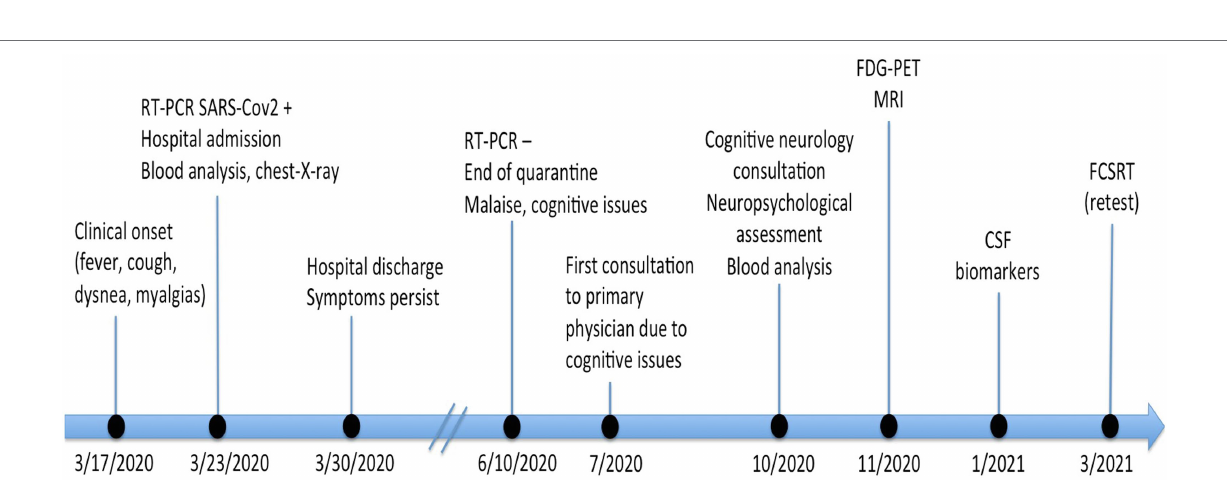
FIGURE 1 | Neuroimaging. Brain MRI (A–C) and FDG-PET (D) . (A) Axial FLAIR, with no white matter hyperintensities; (B) axial SWAN, showing no microbleeds; (C) coronal FSE T2 PROPELLER, with no hippocampus atrophy or ischemic lesions; and (D) FDG-PET showed no regions of hypometabolism visually.